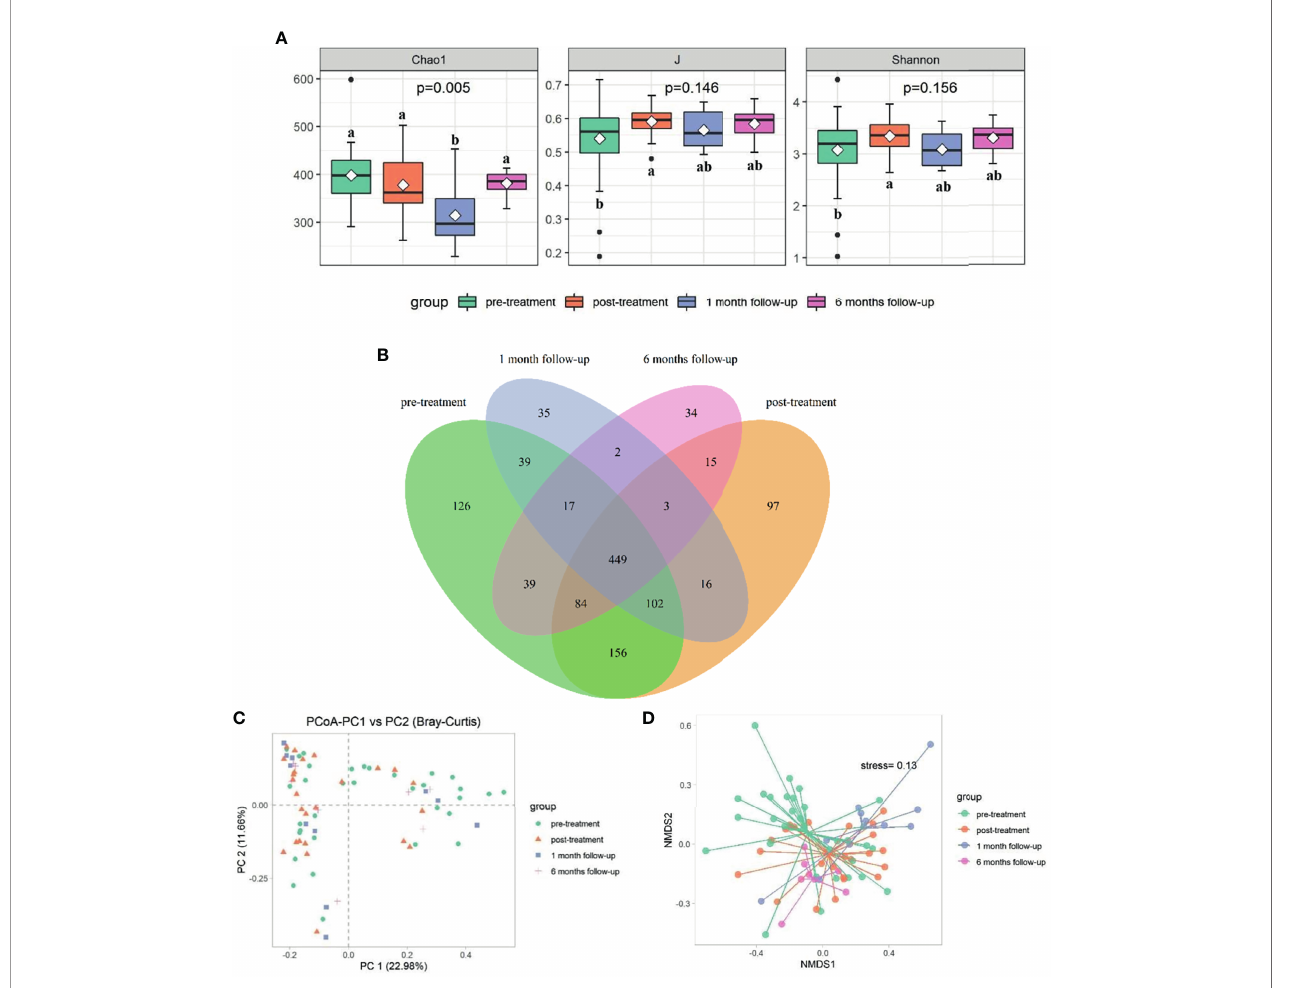
FIGURE 2 | Comparison of bacterial diversity and composition at different time points ( p <0.05). (A) The a diversity indexes comparison including Chao1, J, and Shannon. (B) Venn graph showing the shared and unique OTUs among different groups. The bacterial communities ’ differences among different time points were re fl ected by PCoA plot (C) and NMDS (D) . Letters indicate the difference grouping among different time points. Groups that do not share a common letter are signi fi cantly